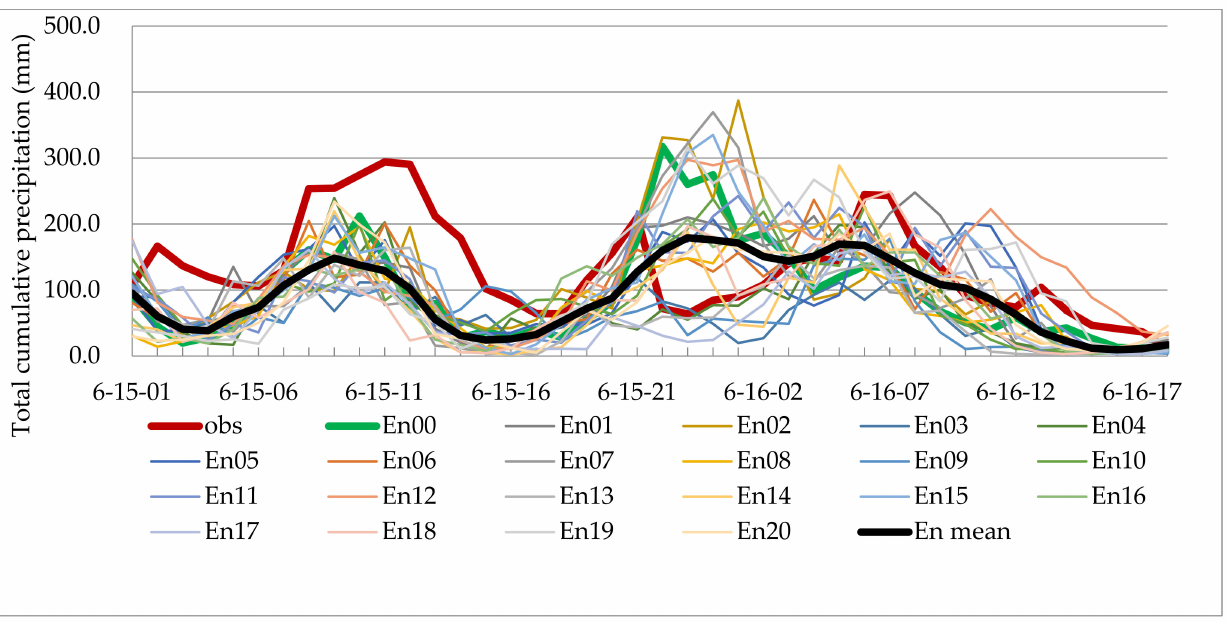
Figure 4. Time series of total cumulative precipitation (mm) over all stations (red line), control run (green line), and 20 ensemble members (thin lines) as well as Enmean (black line) from 01 UTC 15 June to 18 UTC 16 June